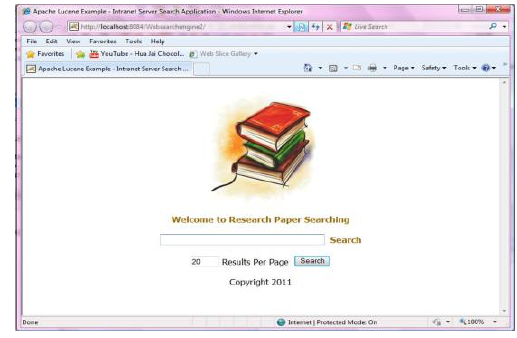
Figure 2. Research Paper Searching web